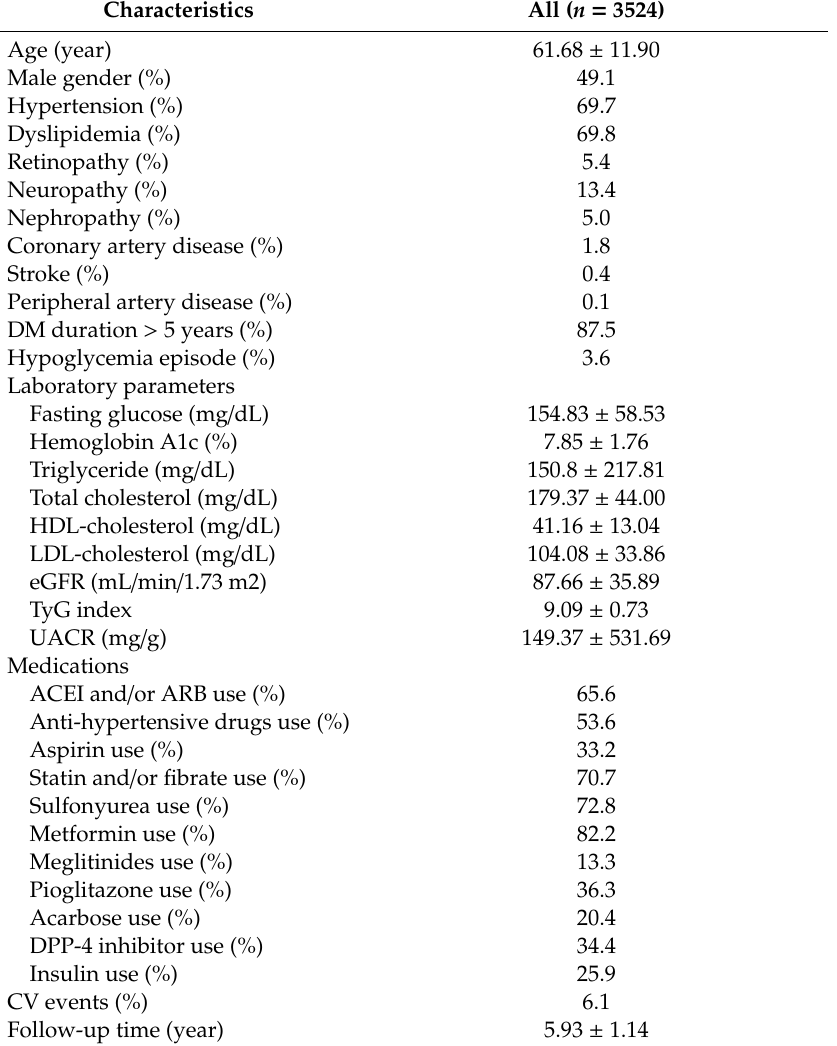
Table 1. Clinical characteristics of the study